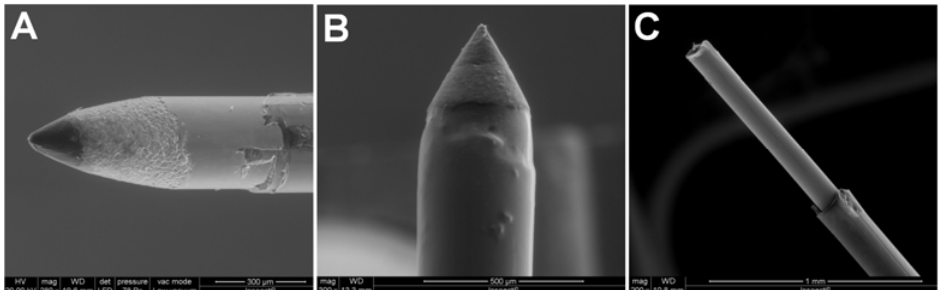
Figure 5. Scanning Electron Microscopy (SEM) microphotographs of (A) ascorbic